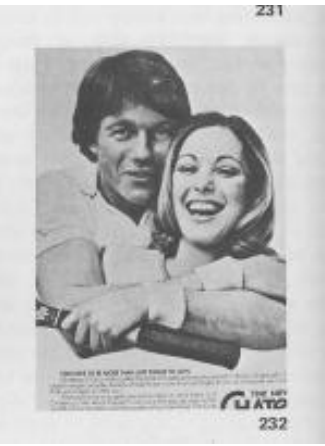
Figure A6. Goffman’s picture women smiles more than men.